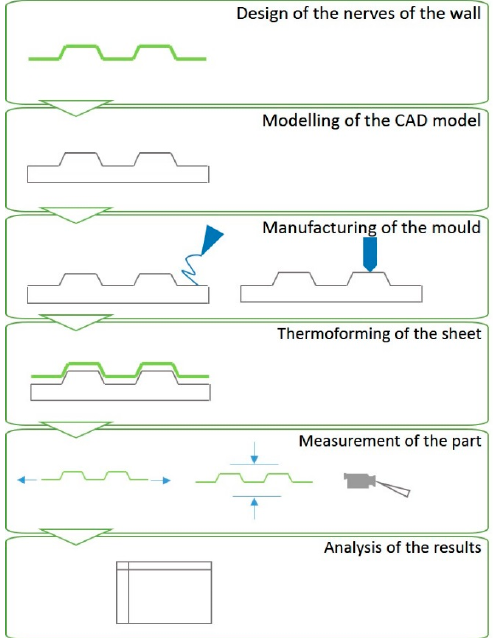
Figure 1. Methodological